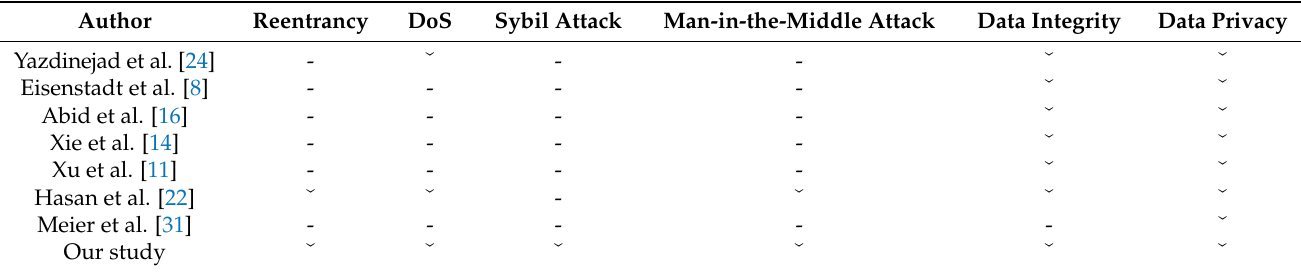
Table 1. Security analysis of existing